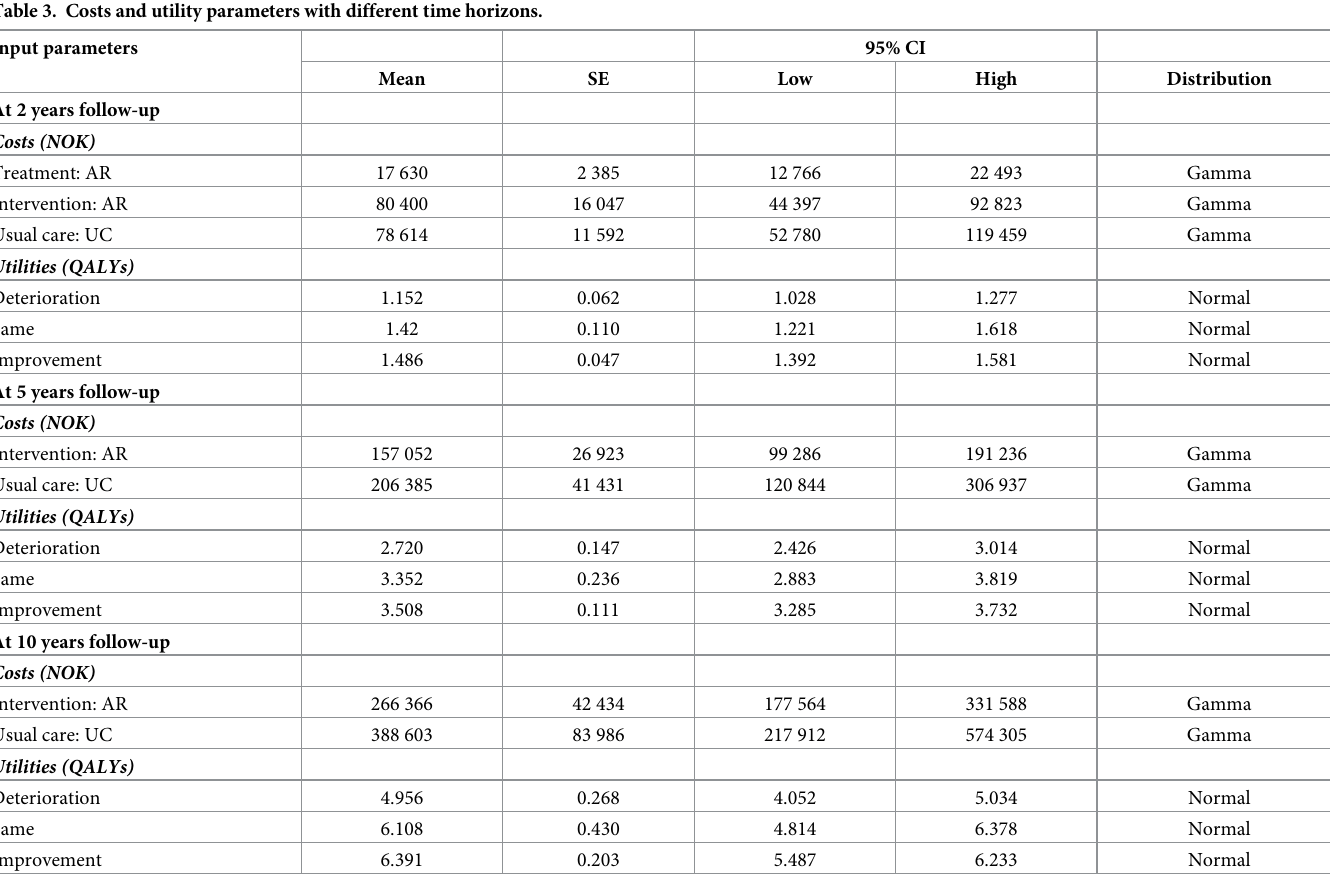
Table 3. Costs and utility parameters with different time